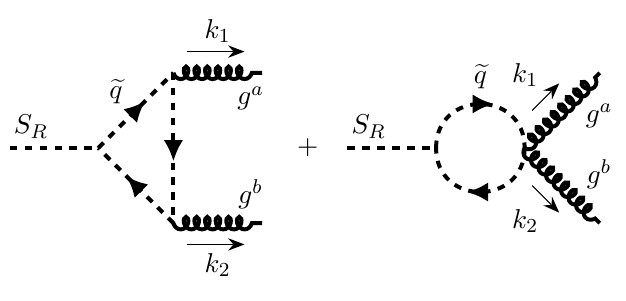
Figure 1 . The Feynman diagrams describing one-loop decay of the singlet to a gluon pair (up to permutation of the final state gluons). This and all subsequent diagrams were created with the aid of the Tikz-Feynman package